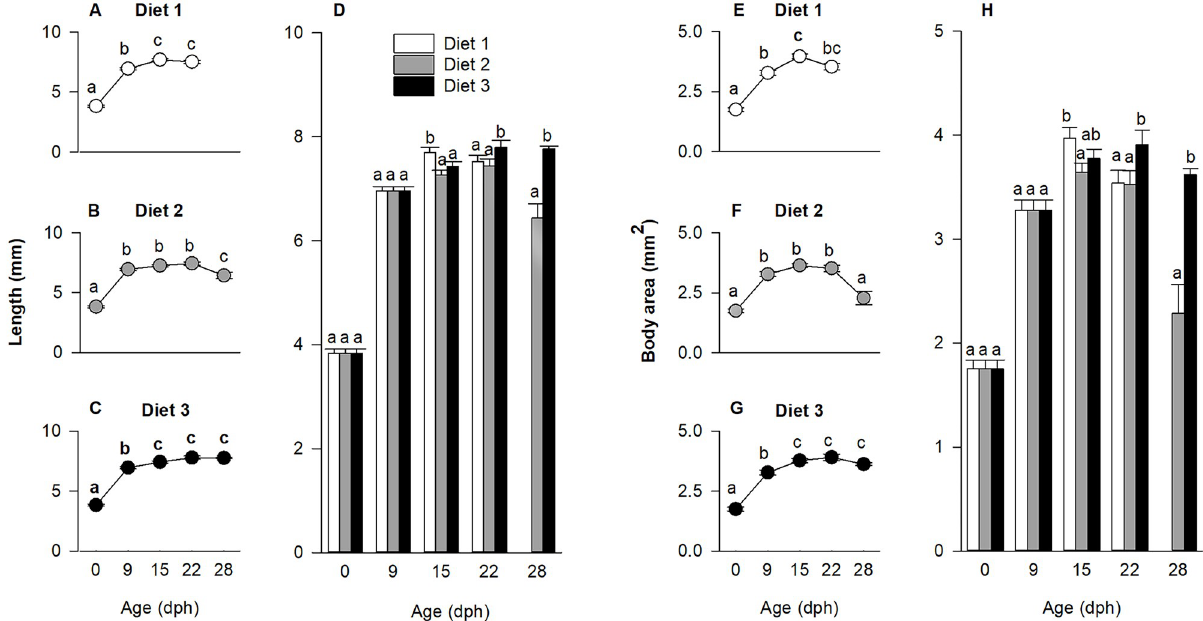
Fig 1. Length and body area in relation to age for larvae of European eel, Anguilla anguilla , fed three experimental diets 1, 2 and 3. Effect of age for each diet on standard length (A-C) and body area (E-G) and effect of diets at each age for standard length (D) and body area (H). Assessment occurred at specific developmental points such as hatch (0 days post hatch (dph)), before first-feeding (9 dph), during first-feeding (15 dph), end of the first-feeding period (22 dph) and beyond the first-feeding period (28 dph). Values represent means ( ± SEM), while different lower-case letters represent significant differences (p <